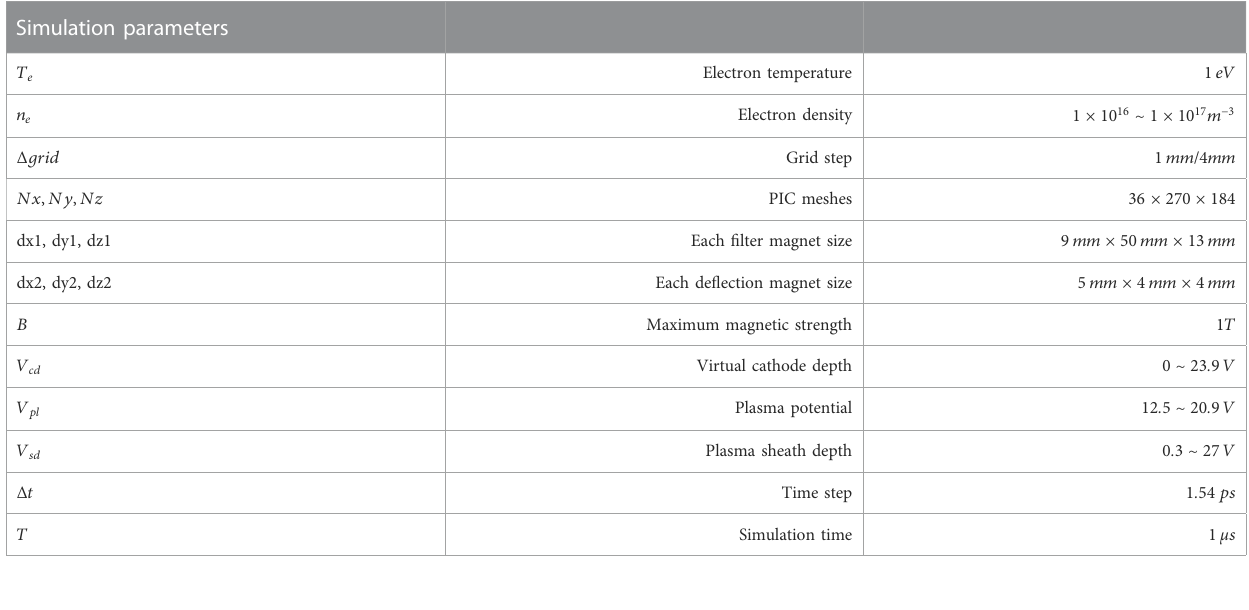
TABLE 2 Simulation parameters used in the code during beam extraction process. Simulation parameters